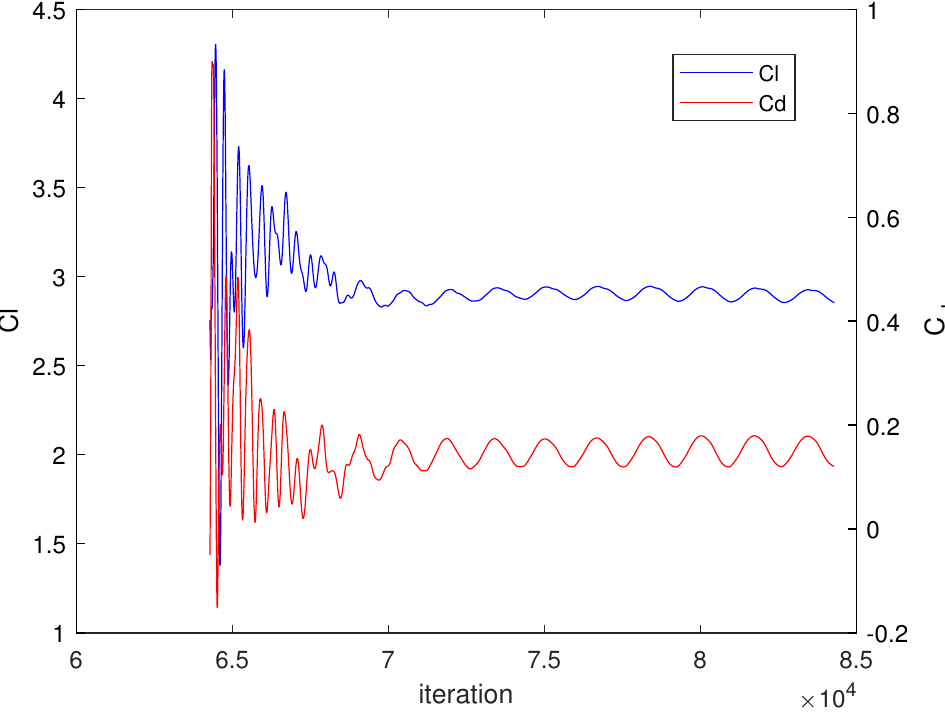
Figure 14. Steady RANS solution of the aerodynamic coefficients from the definitive morphed airfoil for M ∞ = 0.185 and α = 10.1 ◦